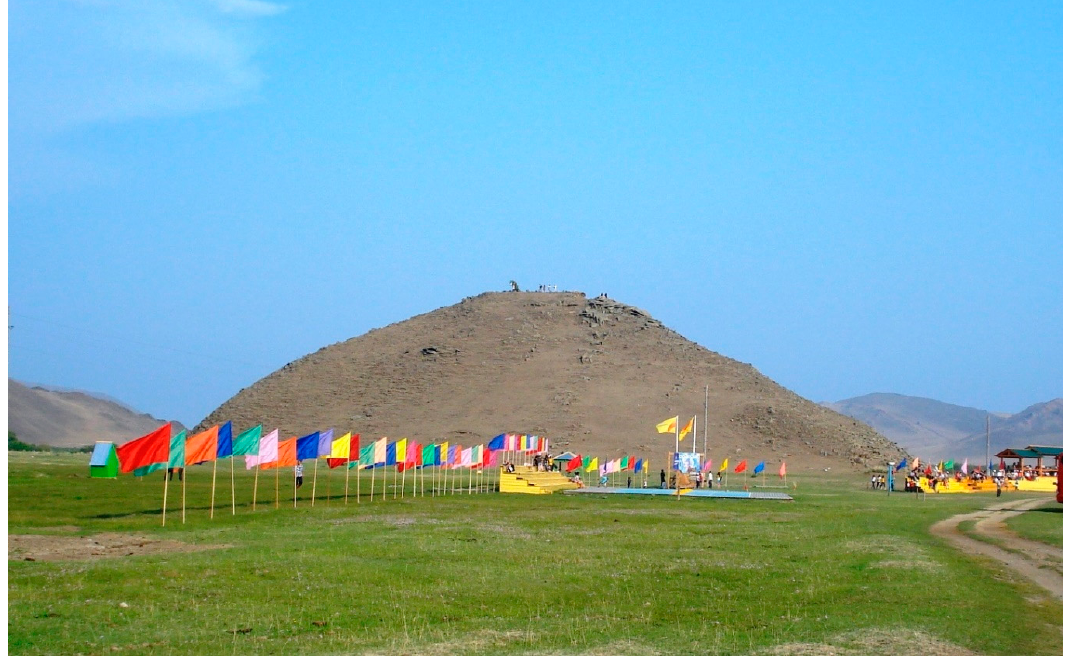
Figure 7. The hill “Yord” in the morning of the first day of the “Games of the Yord” of 2011. Photo: Stefan Krist.